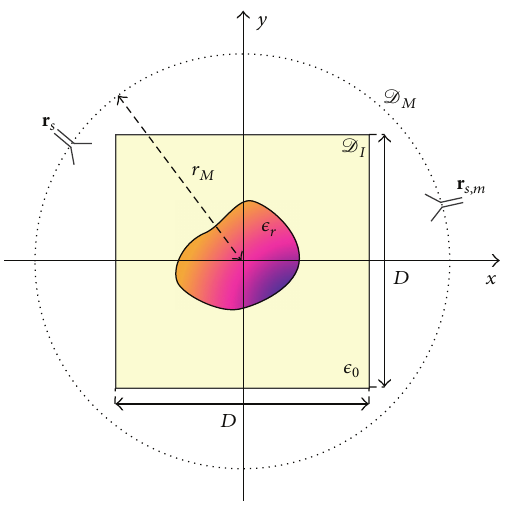
Figure 1: Configuration of the electromagnetic inverse scattering problem and representation of the measurement